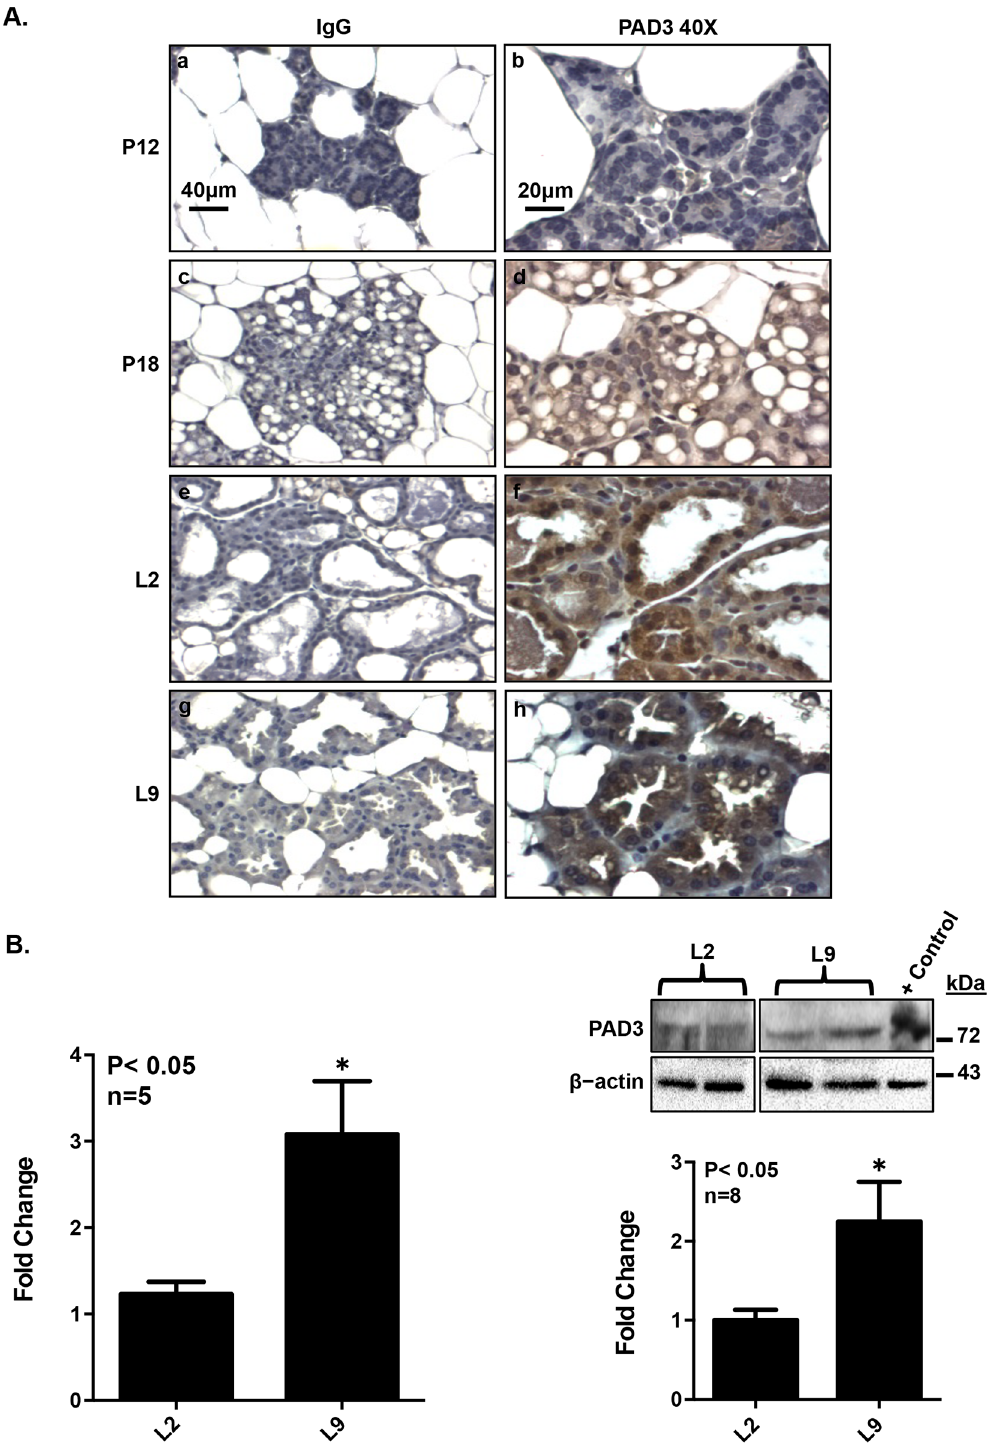
Fig 6. PAD3 expression in mouse mammary secretory cells initiates during late pregnancy and is highest during lactation. (A) PAD3 expression is first detected at P18 and increases from L2 through L9. Mouse mammary tissue from pregnancy day 12 (a, b), day 18 (c, d), lactation day 2 (e, f), and day 9 (g, h) was harvested, fixed in 10% neutral buffered formalin, embedded in paraffin and sectioned. 5 μ m mammary tissue sections were subject to a standard IHC protocol using a rabbit anti-PAD3 antibody or an equal amount of non-specific rabbit IgG as a control. Images were taken with 20 and 40X objectives, and DAB staining represents PAD3 expression. (B) PAD3 mRNA and protein expression increases two-fold between L2 and L9. Total RNA was